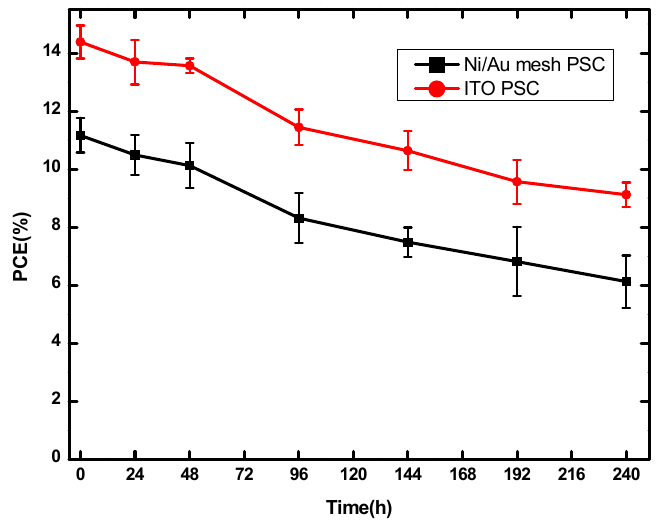
Figure 7. Storing stability of Ni / Au mesh and ITO based PSCs without encapsulation in N 2 for 240 h. What is more, the large-area (1 cm 2 ) Ni / Au mesh-based PSCs are fabricated under the same process conditions as the small-area (0.09 cm 2 ) PSCs. Figure 8a,b shows the J-V curve, photovoltaic parameters, and steady outputs of large-area Ni / Au based PSCs and ITO based reference PSCs. The Ni / Au based PSC obtains a PCE of 6.01%, with V OC = 1.04 V, J SC = 11.28 mA / cm 2 , and FF = 51.28% at the